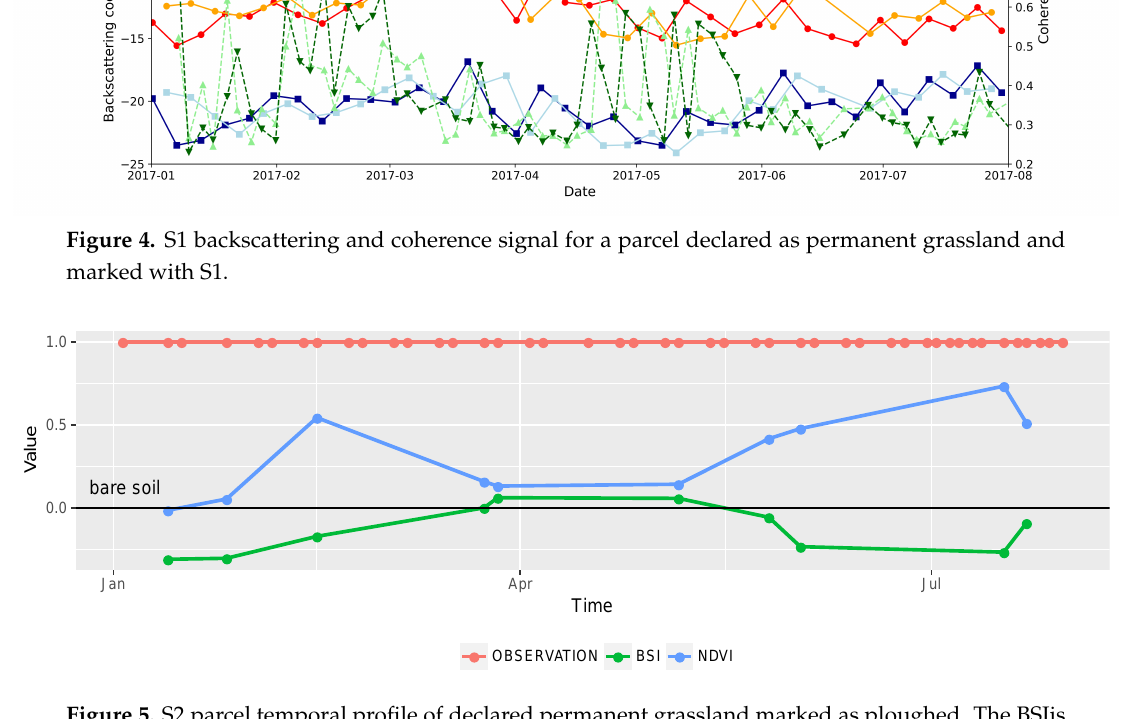
Figure 5. S2 parcel temporal profile of declared permanent grassland marked as ploughed. The BSIis reaching zero at the end of March, indicating a ploughing confirmed visually on Figure 6.